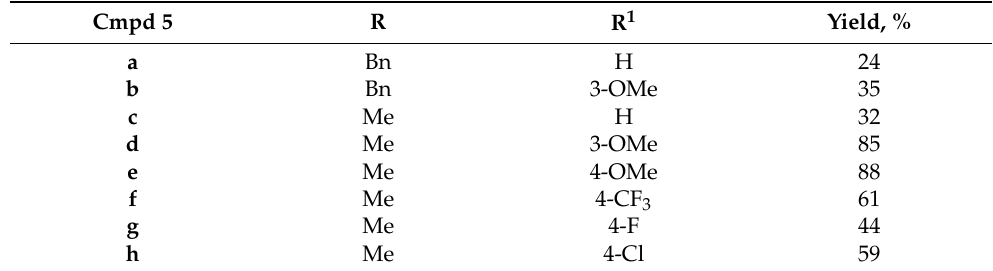
Table 1. 1-R 1 -substituted-phenylethynyl derivatives 5a – h of compounds 3a , c with related synthesis yields.